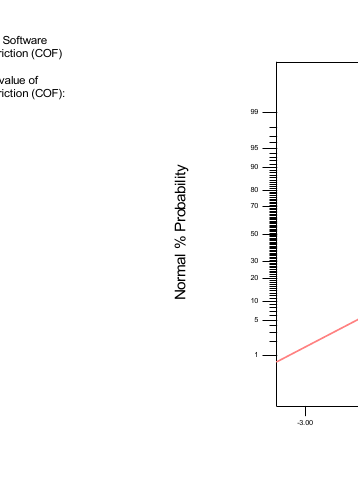
Figure 3. A 3D interaction plot of the COF for the MoS 2 nanolubricant.